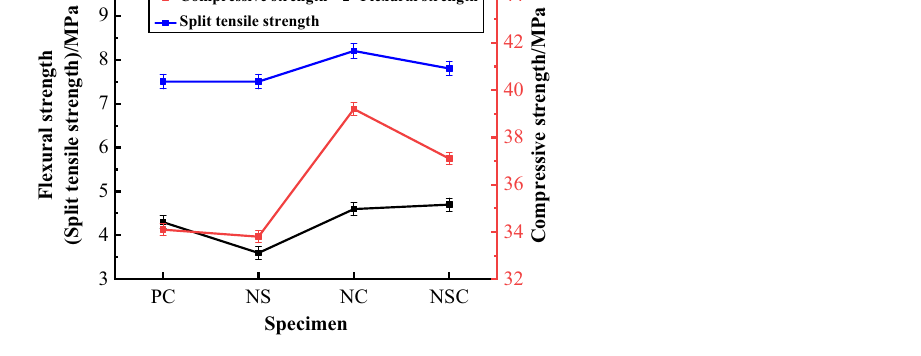
Figure 9. Compressive strength, flexural strength and splitting tensile strength of